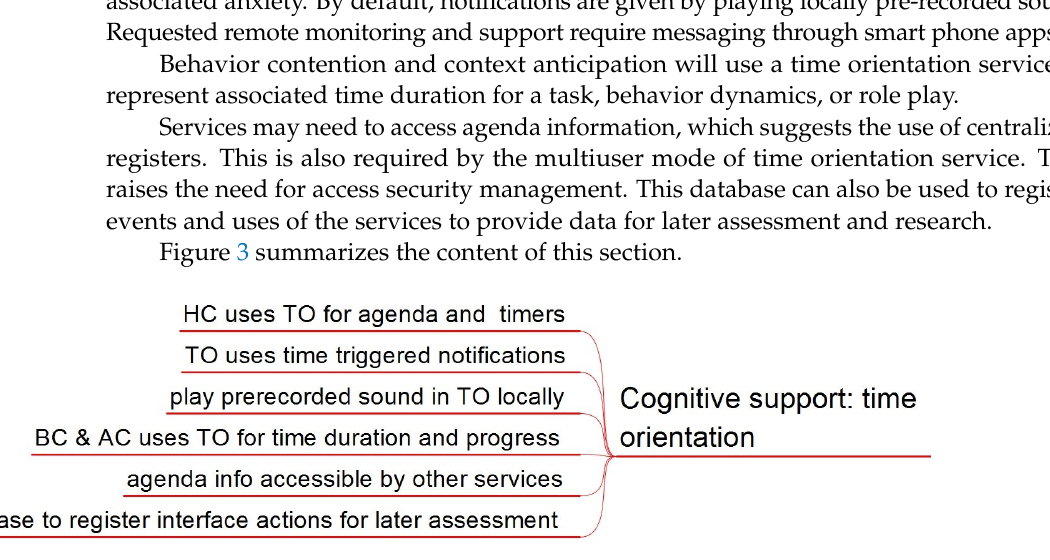
Figure 3. Services requirements for cognitive support in time orientation.